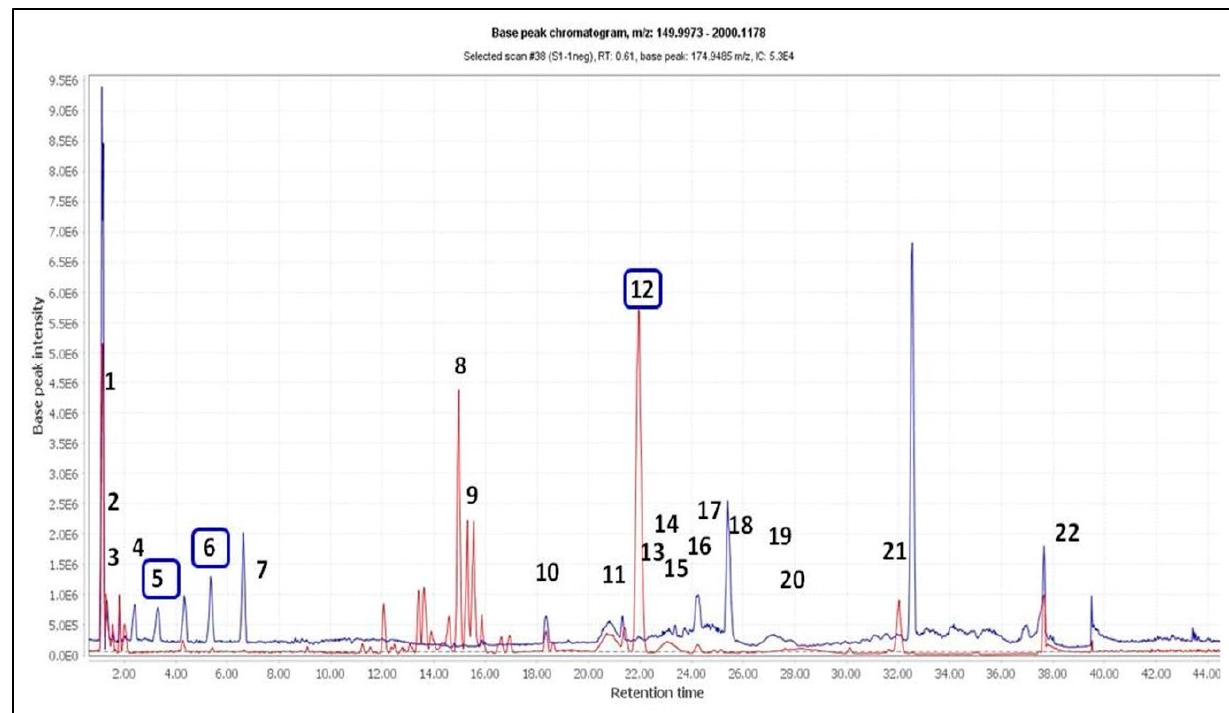
Figure 5. Total ion chromatogram (TIC) of the extract of D. setosum (blue and red represent positive and negative ionization modes, respectively). The dereplication of numbered peaks is shown in Supplementary Table S1. E0: 1.0 × 10 0 ; E5: 1.0 × 10 5 ; E6: 1.0 × 10 6 .